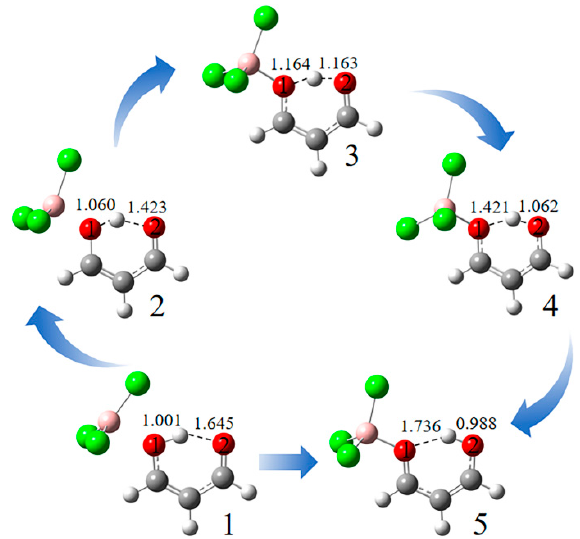
Figure 7. Different conformations in the formation process of MDA-BCl 3 -a.